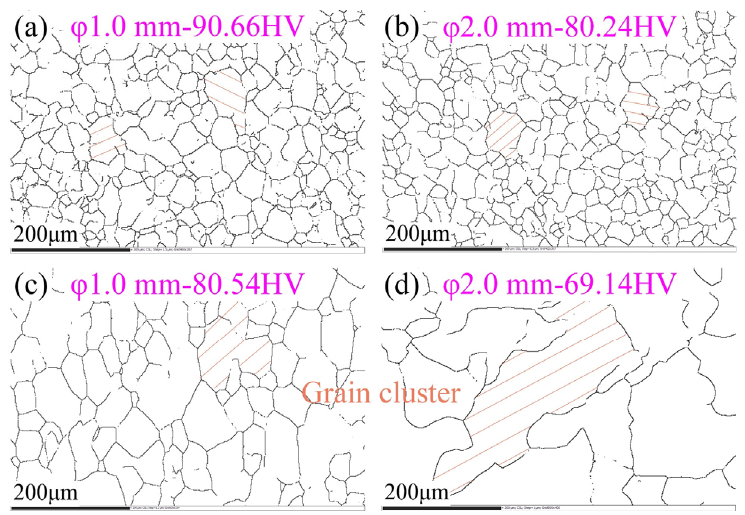
Figure 9. Random boundary distributions corresponding to the maximum and minimum hardness of samples with different diameters: ( a ) φ 1-Uni-2, (b ) φ 2-Uni-2, ( c ) φ 1-Bi-30-2, ( d ) φ 2-Bi-10-1.